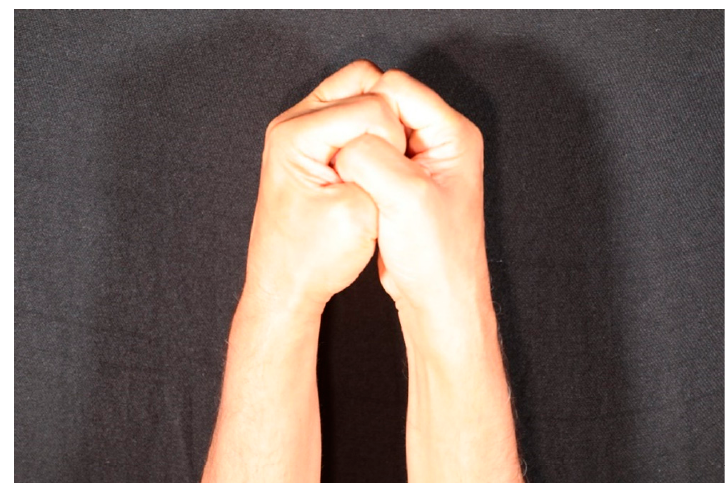
Religions 2021 , 12 , x FOR PEER REVIEW